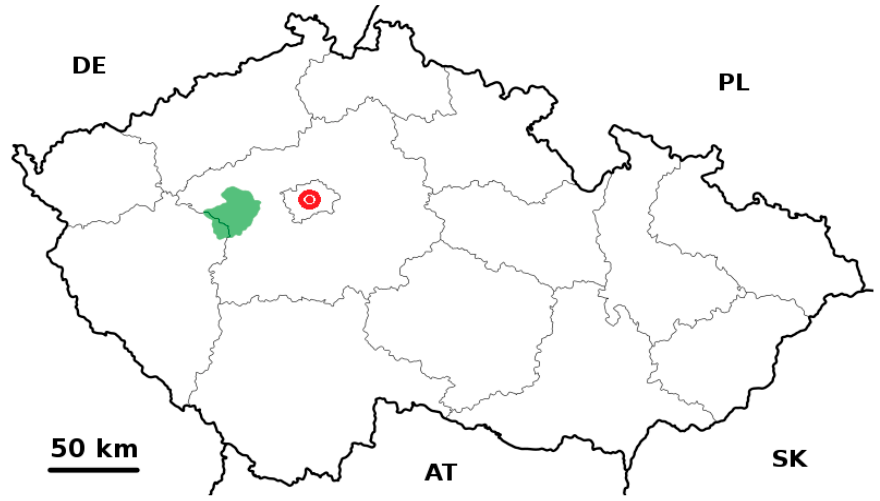
Figure 1. Geographic location of the interest area (green area on the map) of K ř ivoklátsko (Czech Republic).